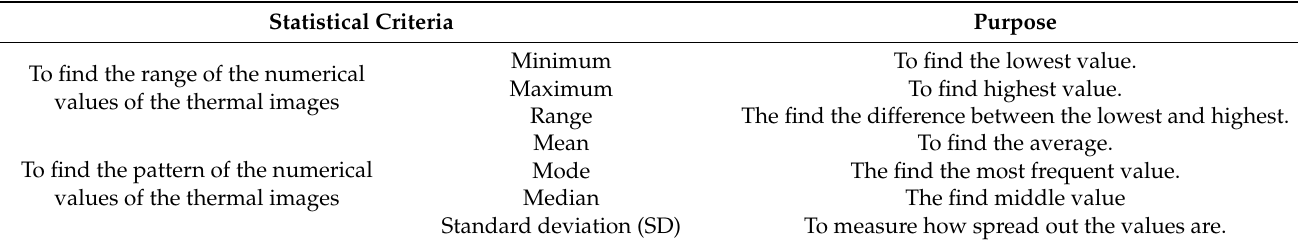
Table 8. Statistical results for thin sample based on transmission mode row thermograms. Table 5. Statistical Analysis criteria.